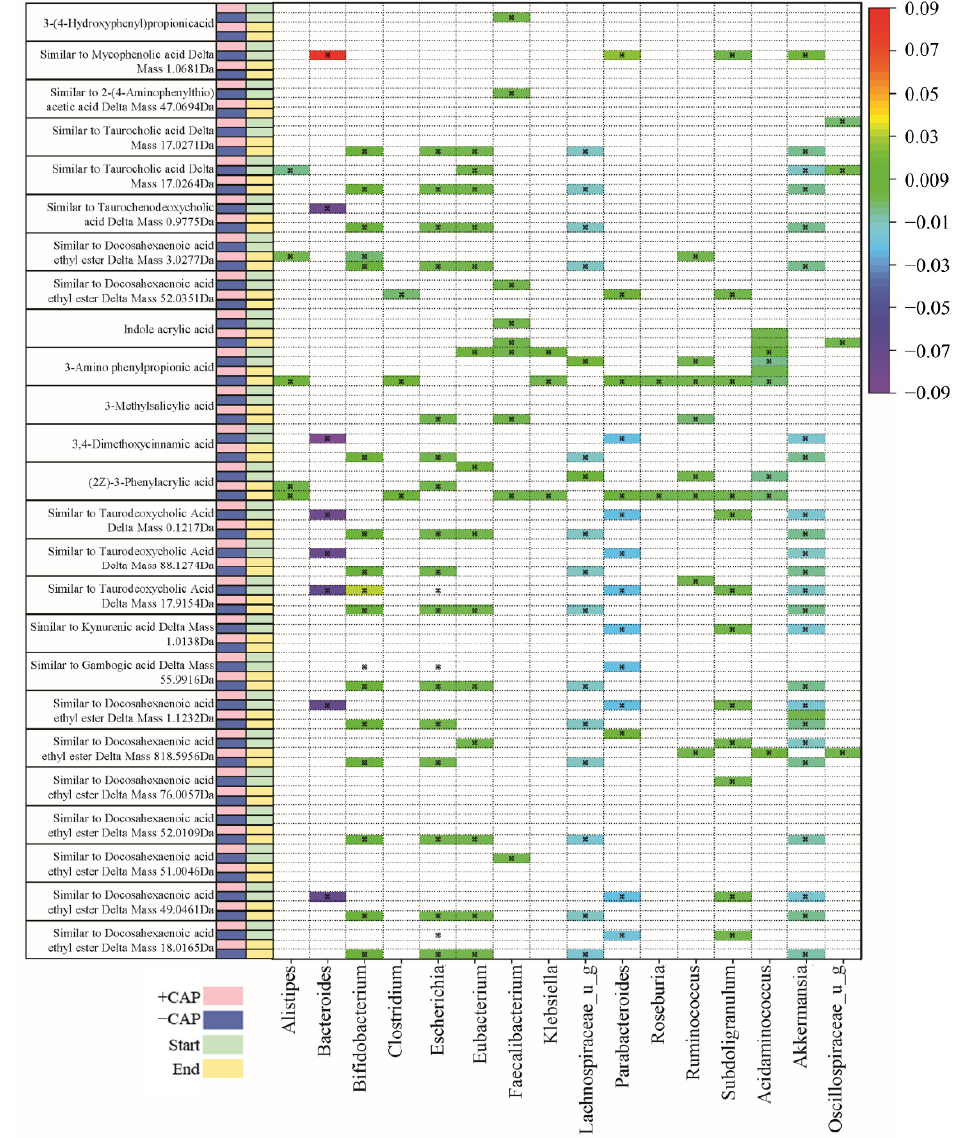
Figure 6. Table of C2 community correlations of metabolites to key bacterial species, from CAP Start to CAP End. Significant correlations were determined by q < 0.05.